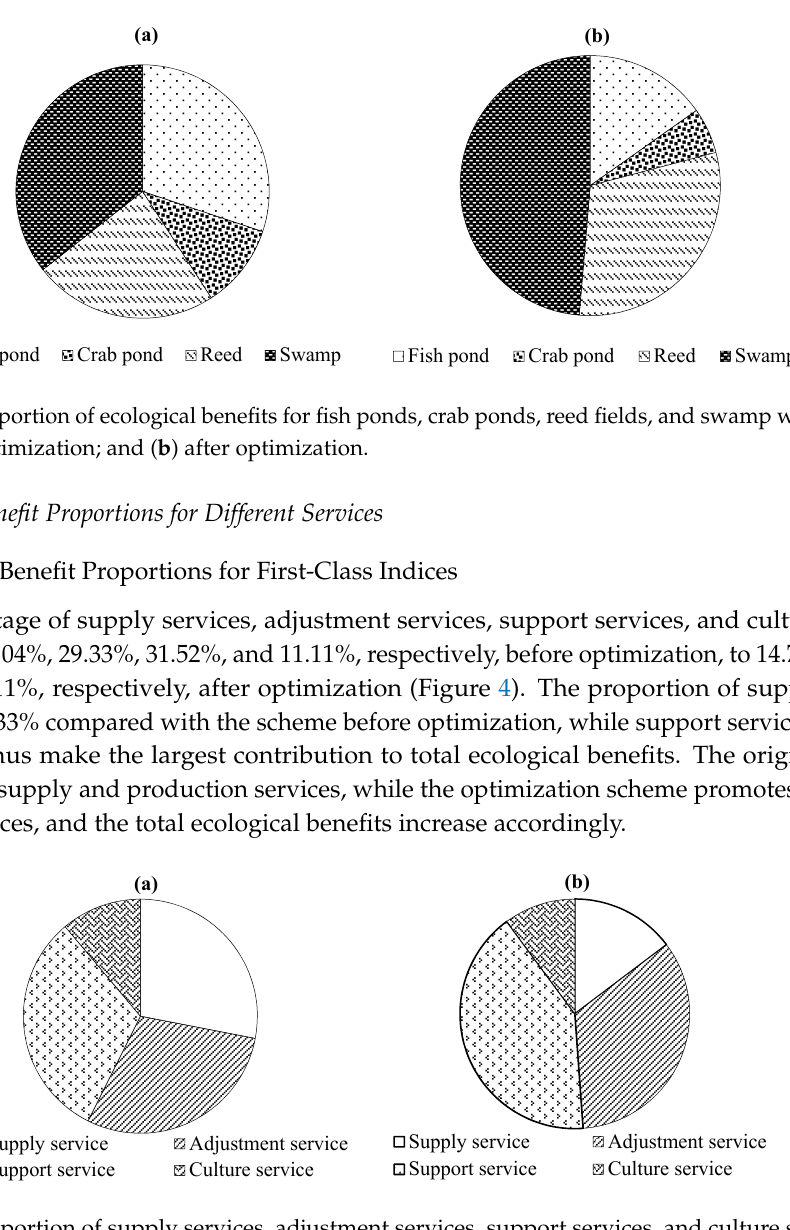
Figure 4. Proportion of supply services, adjustment services, support services, and culture services: ( a ) before optimization; and ( b ) after optimization.